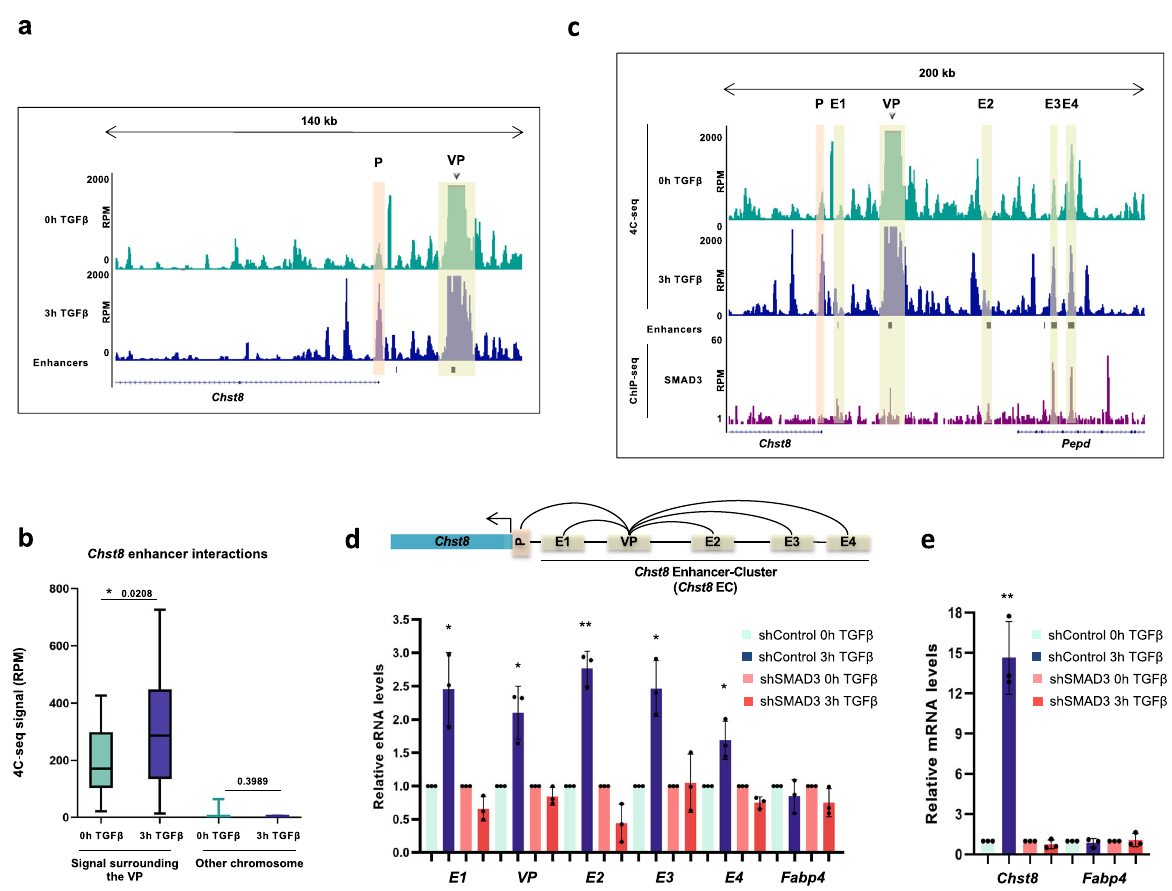
Fig. 2 TGF β drives enhancer-cluster assembly. a UCSC Genome Browser 4C-seq pro fi les generated in NSCs before and upon TGF β addition are shown at the Chst8 promoter and gene body. The light orange box indicates enhancer-promoter contact. The yellow box indicates the VP enhancer (dark arrow). b Boxplot displaying the averaged values obtained from two biological independent replicates of RPM signals of the peaks located 500 kb around the VP - excluding the nearest ± 20 kb - (mm10 chr7:33841896-35860773) in NSCs untreated or treated for 3 h with TGF β . An independent region located in another chromosome (mm10 chr4:33076383-35216108) was tested as a negative control. Boxes comprise values from Q1 to Q3 of the dataset; line corresponds to median value; whiskers show the data range (from min. to max. values within dataset). Depicted quanti fi cations were performed for n = 2 biologically independent samples. p-values are the result of a Wilcoxon-Mann – Whitney test. c UCSC Genome Browser captures showing 4C-seq pro fi les in NSCs untreated or treated (3 h) with TGF β spanning a 200 kb distance around the VP enhancer (dark arrow). ChIP-seq signals of SMAD3 are shown. The positions of enhancers (de fi ned in 33 ) are also displayed. The light orange box indicates enhancer-promoter contacts; yellow boxes show enhancer- enhancer contacts. d , e The top panel shows a scheme summarizing the enhancer-enhancer and enhancer-promoter contacts identi fi ed in the 4C-seq experiment. The bottom panel shows the treatment of control NSCs or shSMAD3 NSCs for 3 h with TGF β . d shows eRNA levels from the indicated enhancers and e shows mRNA from the indicated genes quanti fi ed by RT-qPCR. Transcription values were normalized to the housekeeping gene Gapdh and the fi gure shows values relative to the untreated samples. Progesterone-responsive Fabp4 eRNA was used as a negative control. Results are the mean of three biologically independent experiments. Data are presented as mean values + / − SEM. * p < 0.05; ** p < 0.01 ( P values were calculated using two-tailed Student ’ s t test, p = 0.03229859 ( E1 ), p = 0.04082807 ( VP ), p = 0.00839842 ( E2 ), p = 0.02618772 ( E3 ), p = 0.01592669 ( E4 ) and p =